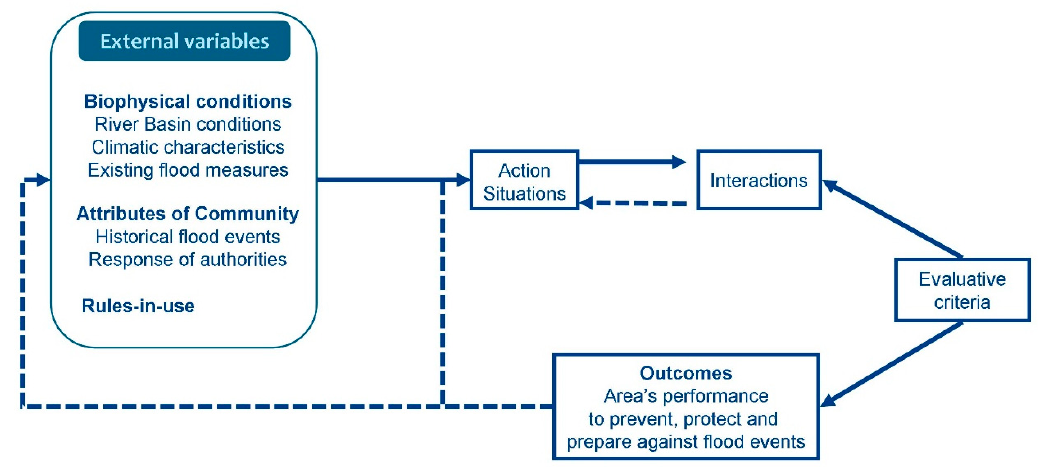
Figure 2. IAF of flood risk management decision making.